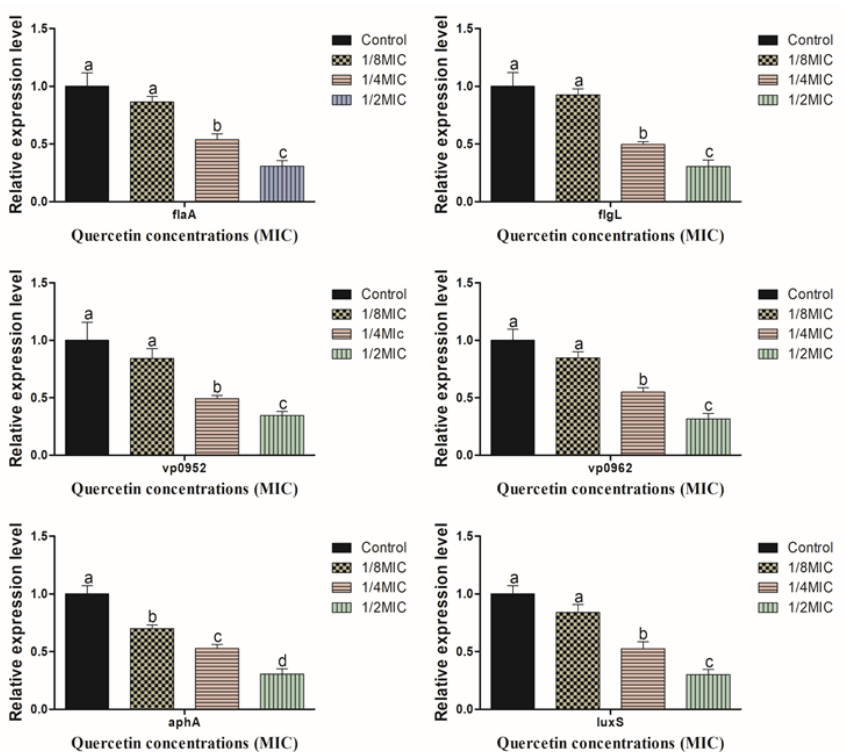
Figure 6. Relative expression levels of flaA, flgL, vp0952, vp0962, aphA , and luxS genes in Vibrio parahaemolyticus supplemented with sub-MICs of quercetin. a–d Different superscript letters indicate significant differences ( p < 0.05) with three independent replicates.